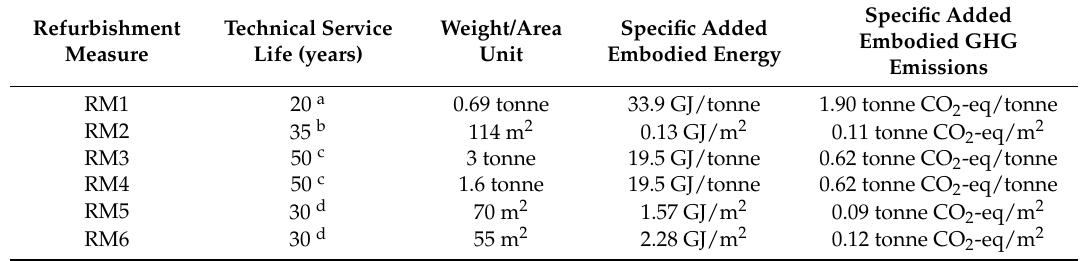
Table 3. Information about the refurbishment measures made in the case